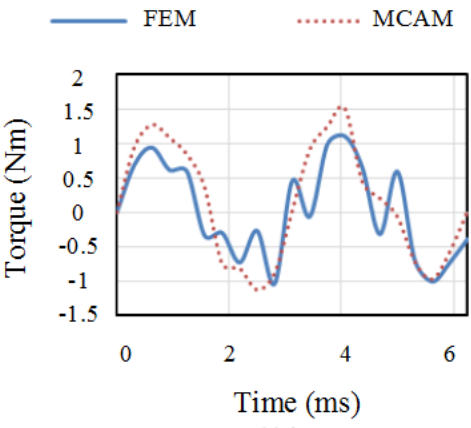
Figure 7. Analysis of positioning torque of AFPMSM.